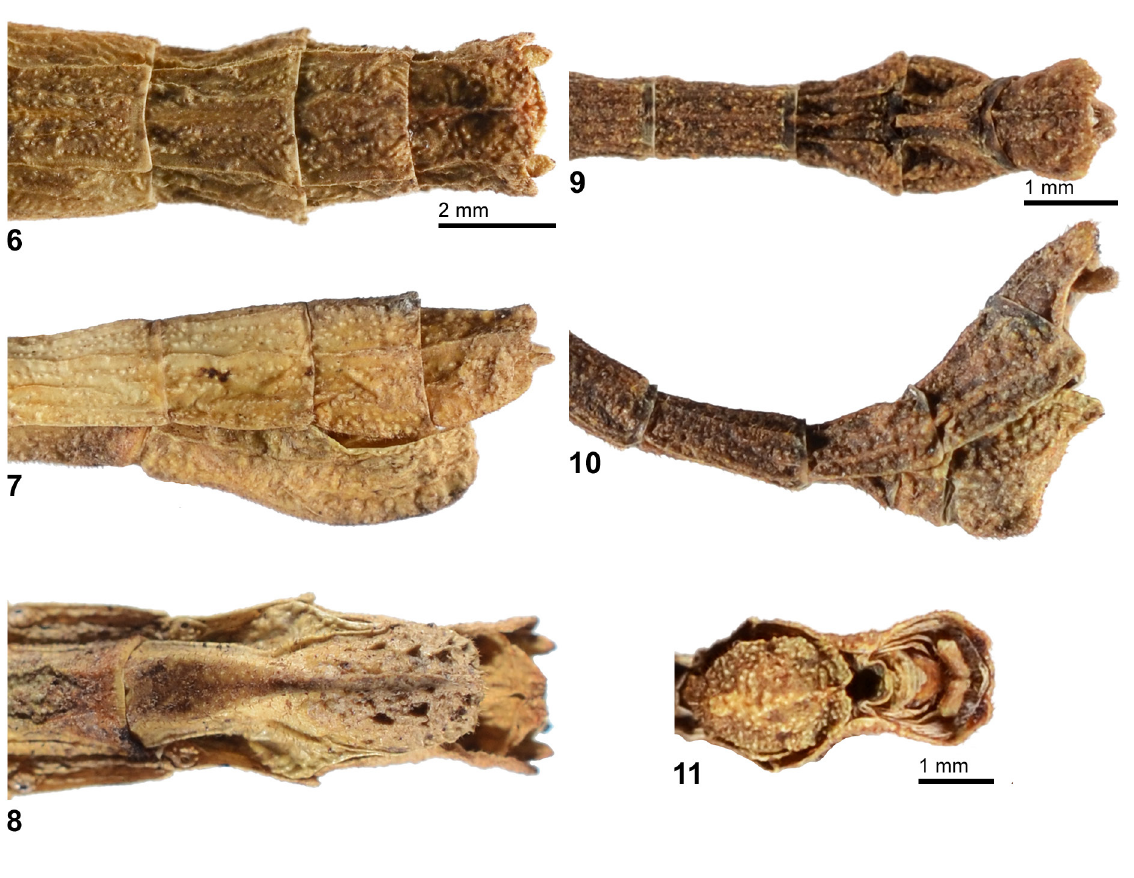
Figs 6–11. Lobolibethra carbonelli sp. nov. 6 . ♀, PT: apex of abdomen in dorsal view (FH, 0569-10). 7 . ♀, PT: apex of abdomen in lateral view (FH, 0569-11). 8 . ♀, PT: apex of abdomen in ventral view (FH, 0569-10). 9 . ♂, PT: apex of abdomen in dorsal view (FH, 0569-23). 10 . ♂, PT: apex of abdomen in lateral view (FH, 0569-20). 11 . ♂, PT: apex of apex of abdomen in ventral view (FH,